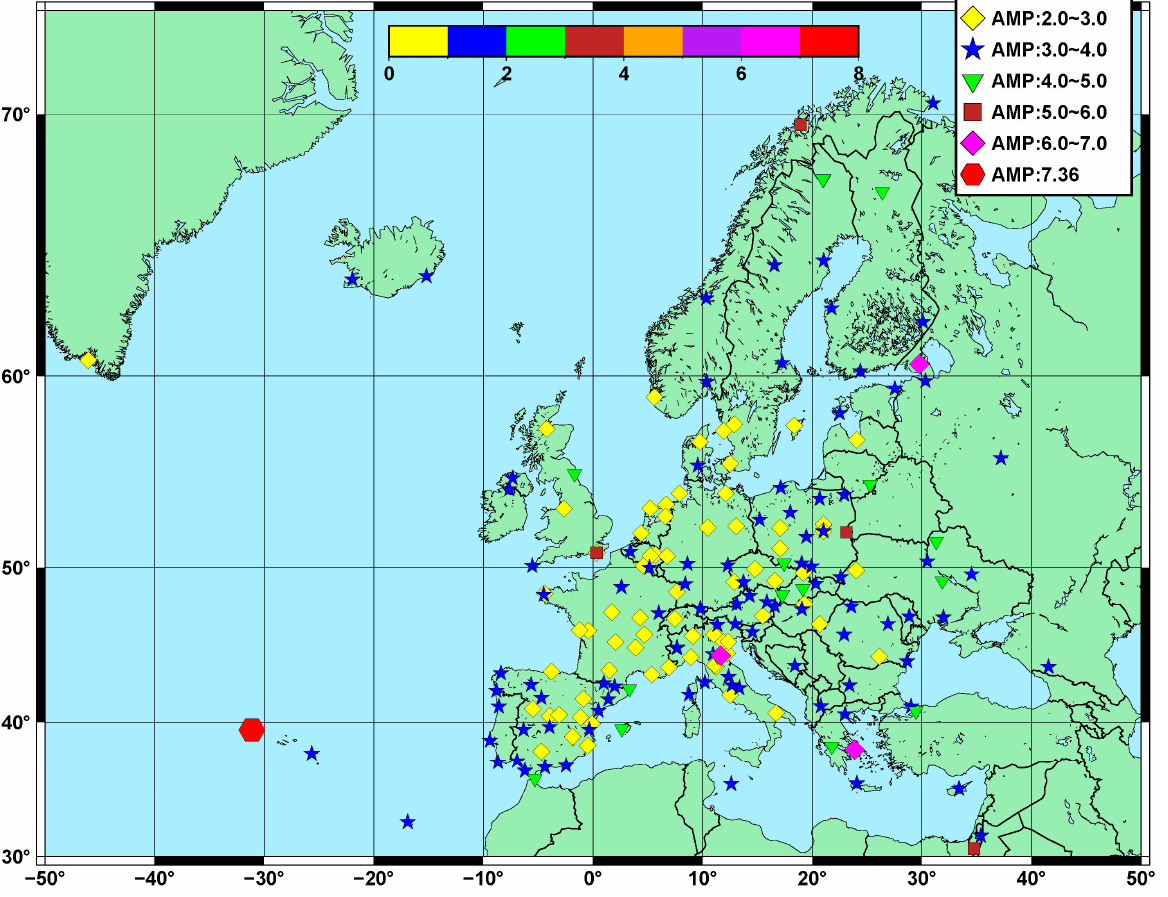
Figure 5. Noise amplitude for the East component.